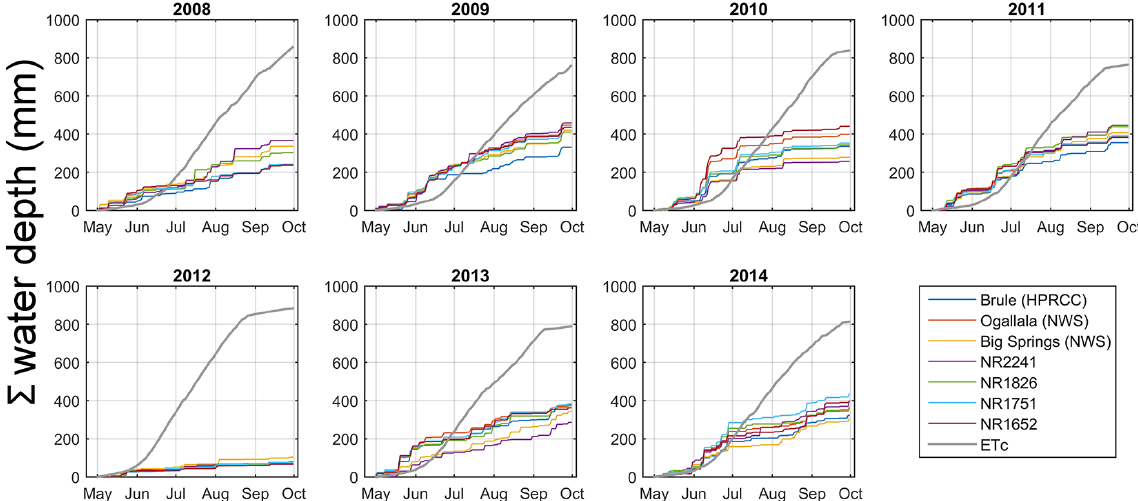
Figure 3. Cumulative in-season precipitation depths measured at seven rain gauges and crop referenced evapotranspiration (ET c ) calculated from a weather station < 10km away. Precipitation variability tends to increase with increasing seasonal totals.